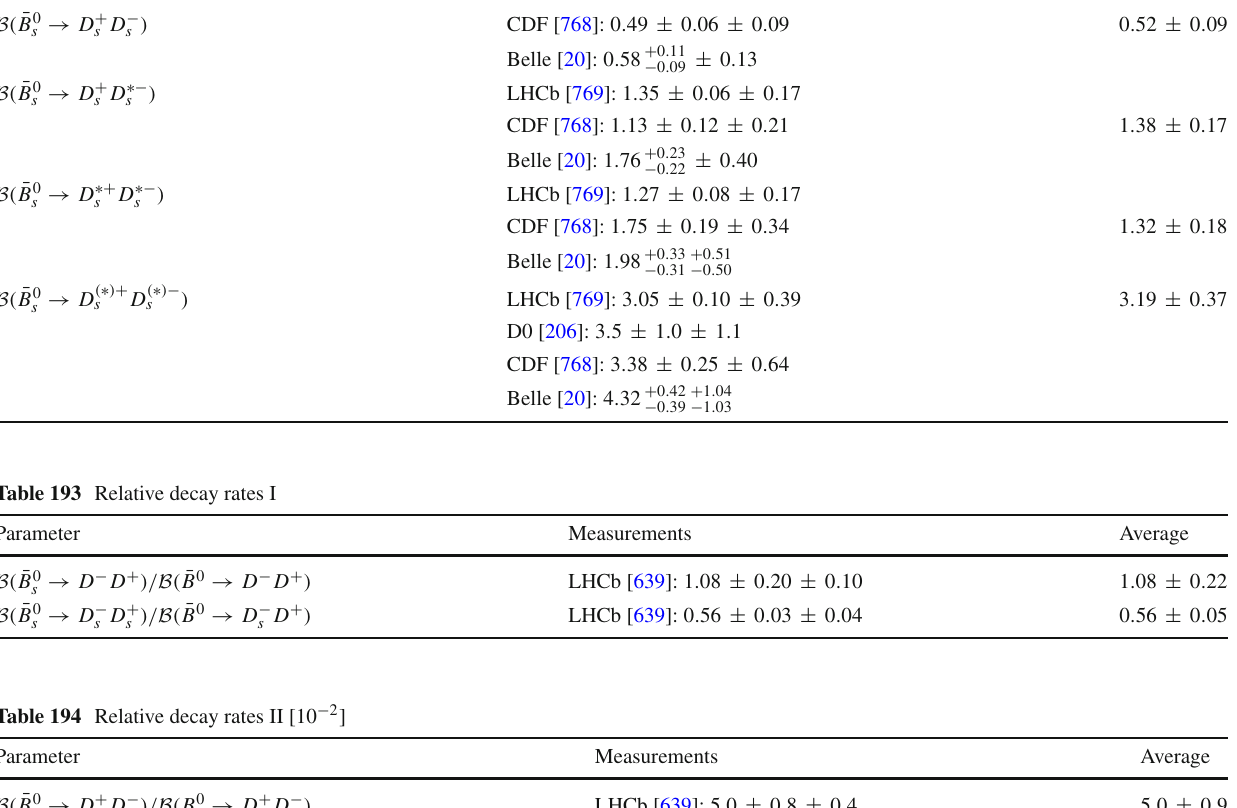
¯ B 0 Averages of decays to two open charm mesons are shown in Tables 192, 193, 194 and Figs. 158, 159, 160. s